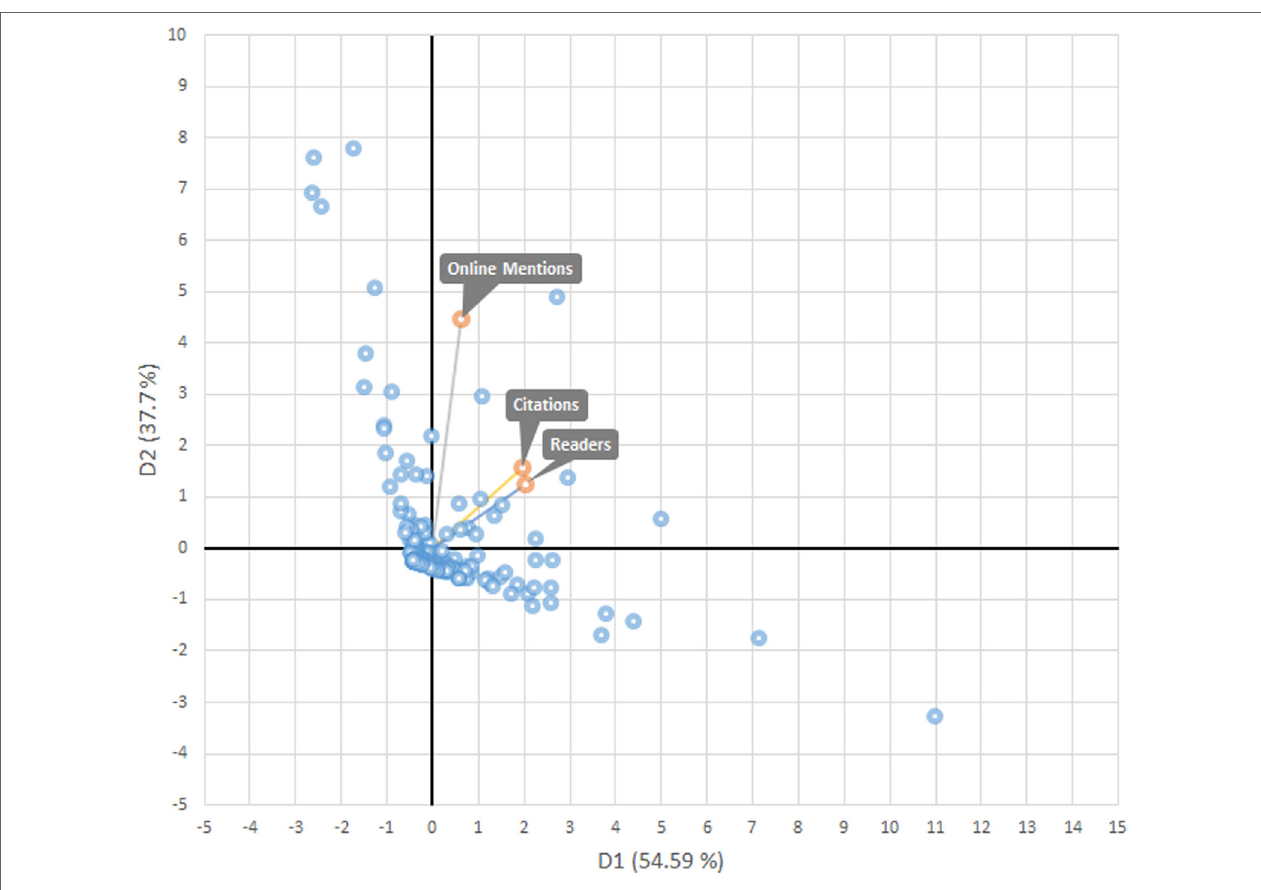
FigUre 5 | Principal component analysis of author-level metrics ( n =